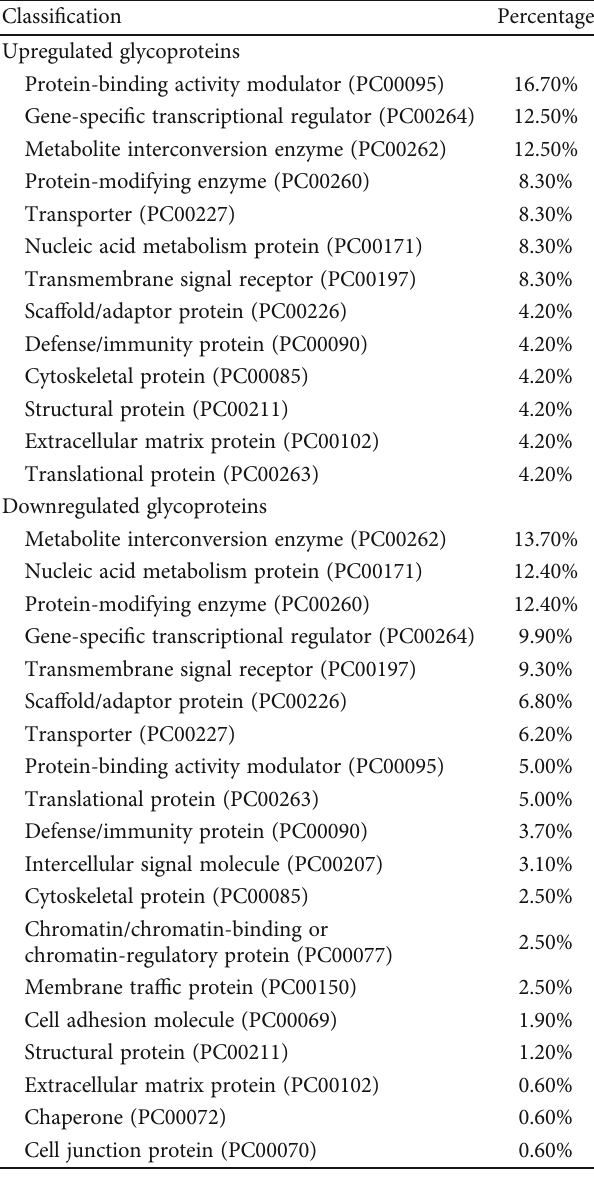
Table 5: Glycoprotein classi fi cation in AD patients: upregulated and